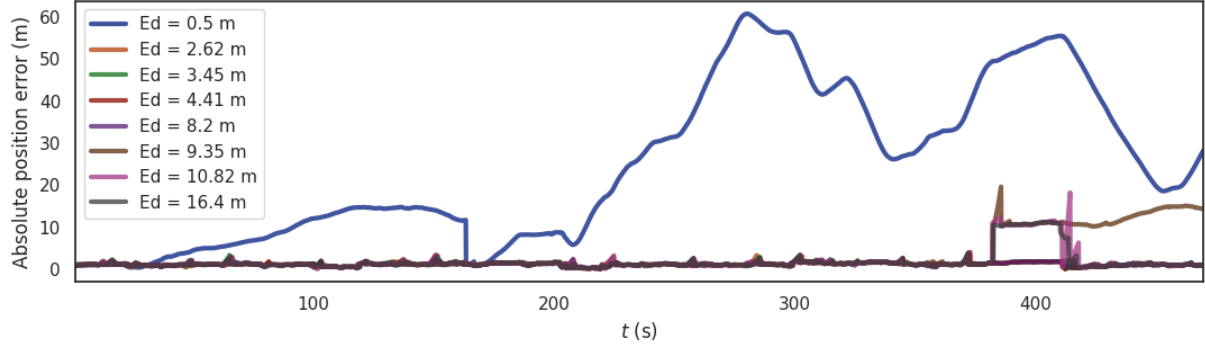
Figure 8. The trend of APE under different localization verification thresholds of forwarding spoofing.